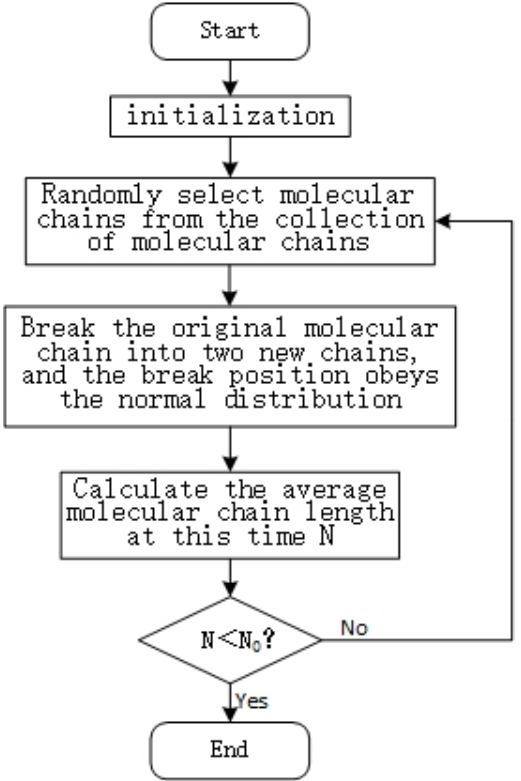
Figure 5. Molecular chain break model solution flowchart. The molecular chain length distribution of PMVS under different L u is shown in Figure 6.